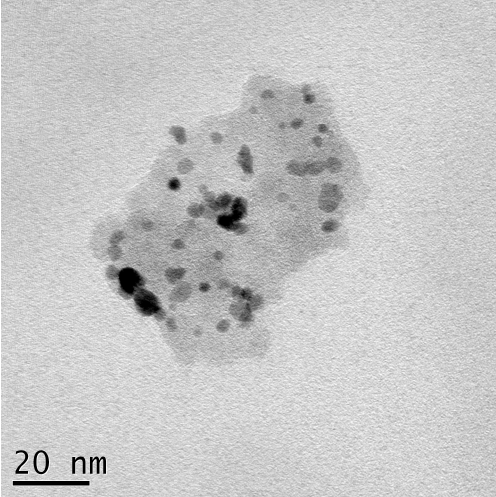
Figure 3. Transmission electron micrograph of Ru@SiO 2 particles with a Ru/Si atomic ratio of 0.4.